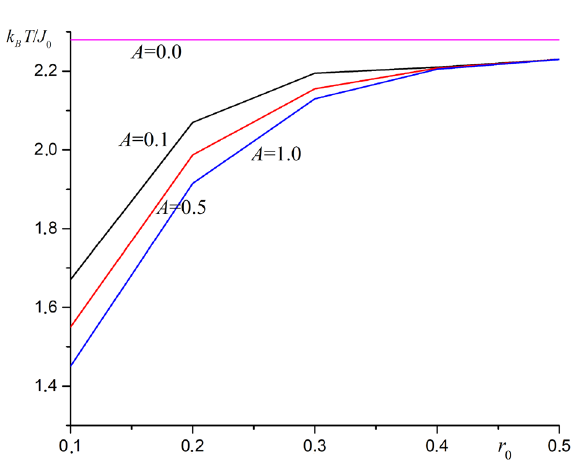
Figure 3. The graph for phase transition temperature versus parameter r 0 for the case substrate stretching ( b = 1.05 a 0 ) at different substrate potential amplitude